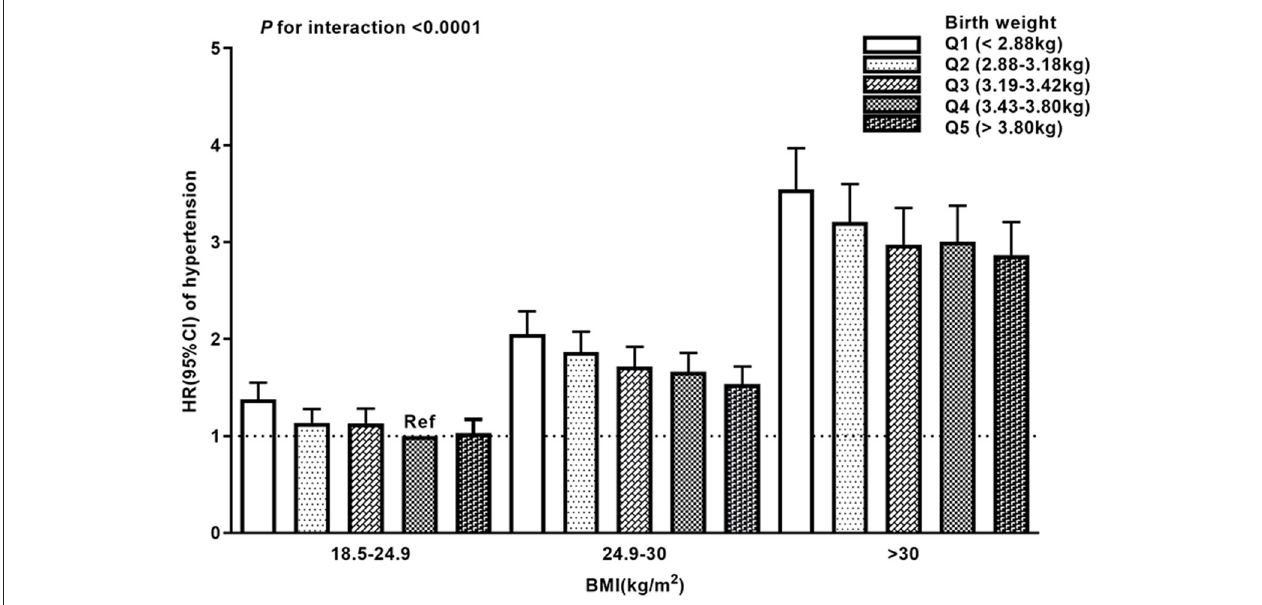
FIGURE 2 | Joint analysis of birth weight and body mass index (BMI) in the full model. The participants with birth weight in group Q4 (3.43–3.80kg) and BMI in adult between 18.5–25.0 kg/m 2 were treated as the reference group (Ref). Error bars represent 95% confidence intervals of the hazard ratios.